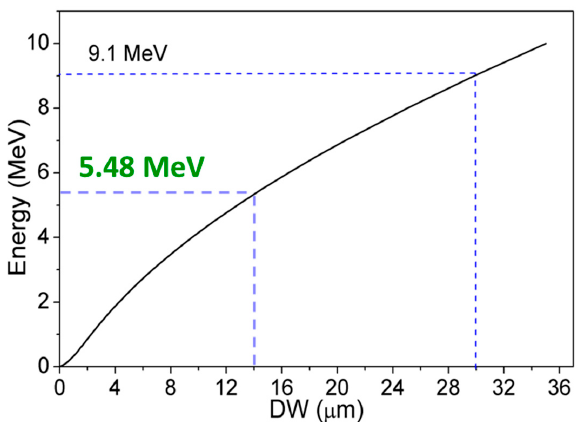
Figure 7. α -particle range in GaN calculated by stopping range of ions in matter (SRIM).